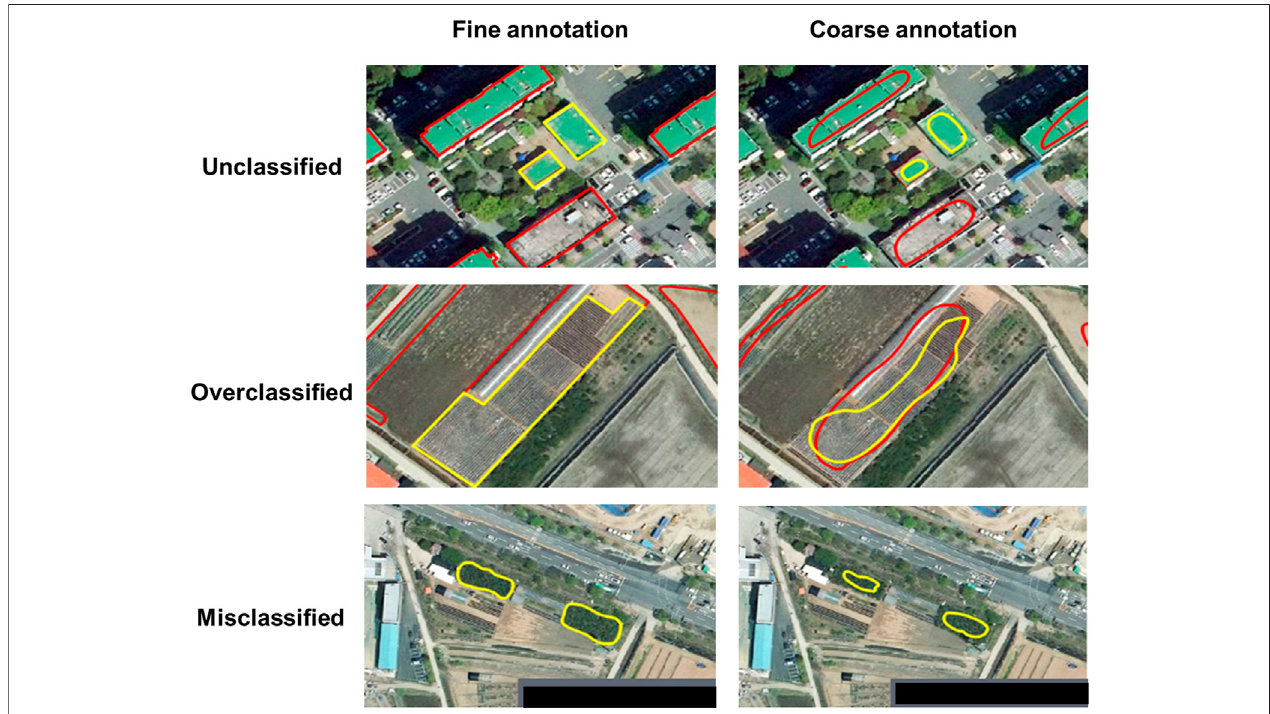
FIGURE5| ExamplesofFineandCoarseannotationerrortypes.Theredlineistheannotationstatus,andtheyellowlineistheannotationthatneedstobeaddedor modi fi ed.